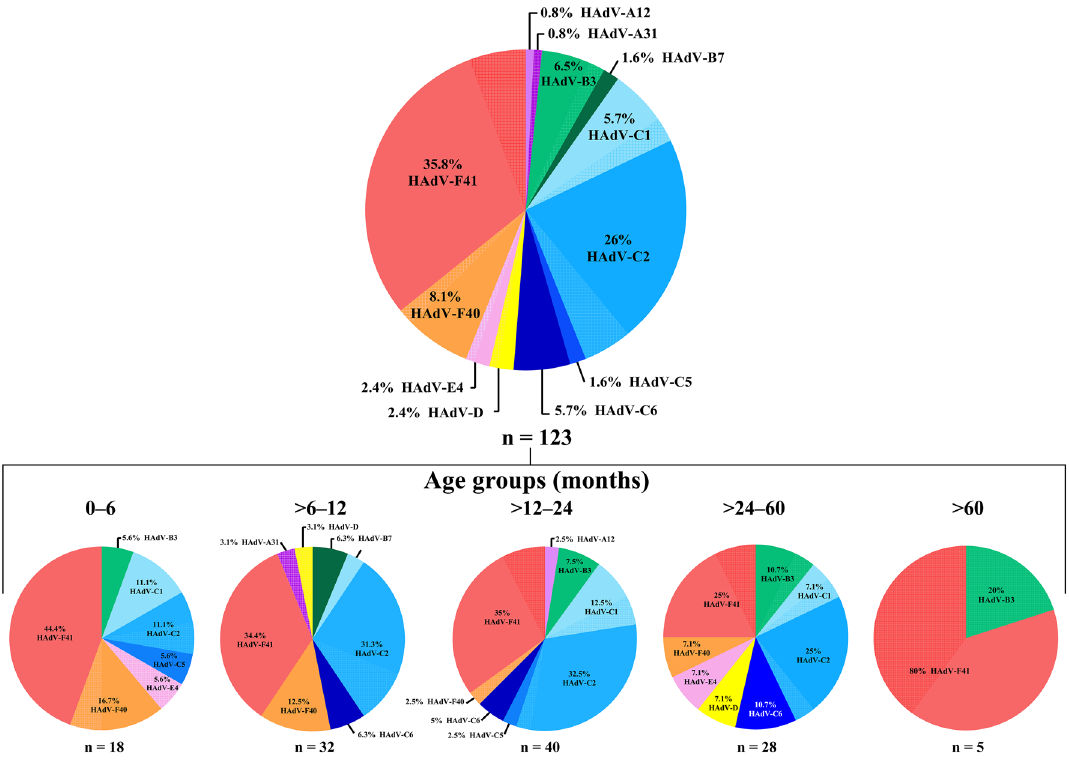
Figure 3. The total frequency of HAdV types obtained from sequenced samples and types percentage distribution by age groups. HAdV types obtained from co-detections with rotavirus or norovirus are represented by a crosshatched pattern.